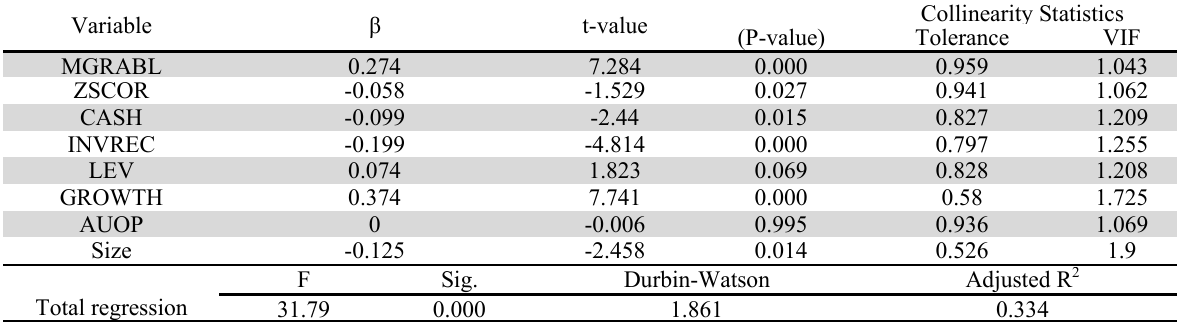
The summary of regression